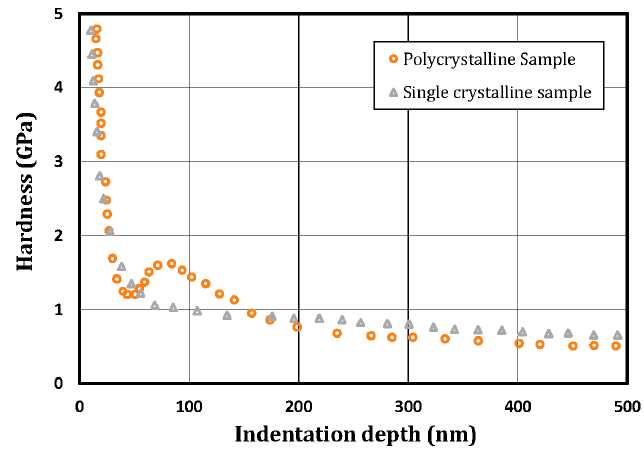
Figure 8. Comparison of the nanoindentation response of a single crystalline Al sample with that of a polycrystalline one at strain rates of 0.1 s − 1 . The original data were reported by Voyiadjis et al. [106]. Voyiadjis and Zhang [107] and Zhang and Voyiadjis [108] investigated the effects of GB on the nanoindentation response of bicrystalline Al and Cu samples, respectively. They varied the distance of indentation from the GB and compared the observed nanoindentation responses (Figure 11). The results showed that the distance from the GB controls the depths at which different regions of hardening occur in a way that the local hardening occurs at lower indentation depths for indentations closer to the GB. As the indentation distance becomes large enough, the response becomes similar to that of a single crystalline sample. Accordingly, Zhang and Voyiadjis [108] proposed a material length scale that incorporates the effect of distance between the GB and indenter tip r based on the